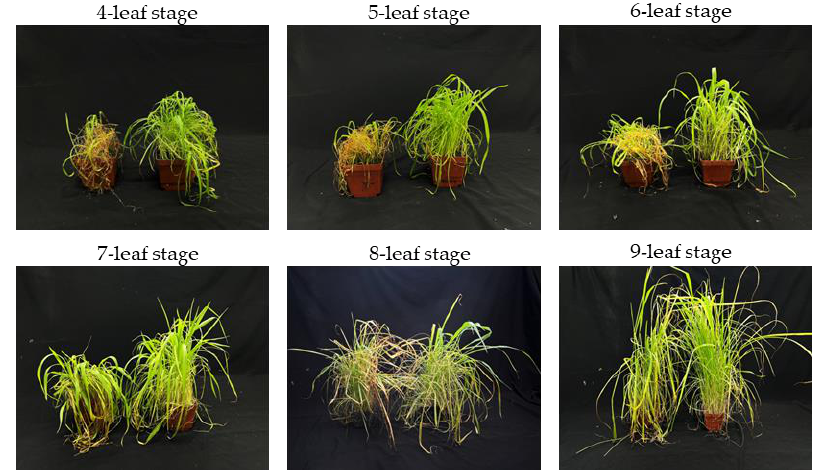
Figure 4. Effect of C. echinochloae B-48 on different weed growth stages. Table 4. Efficacy of C. echinochloae B-48 in controlling barnyardgrass at different growth stages. Leaf Stage Fresh Weight Inhibition Rate (%)